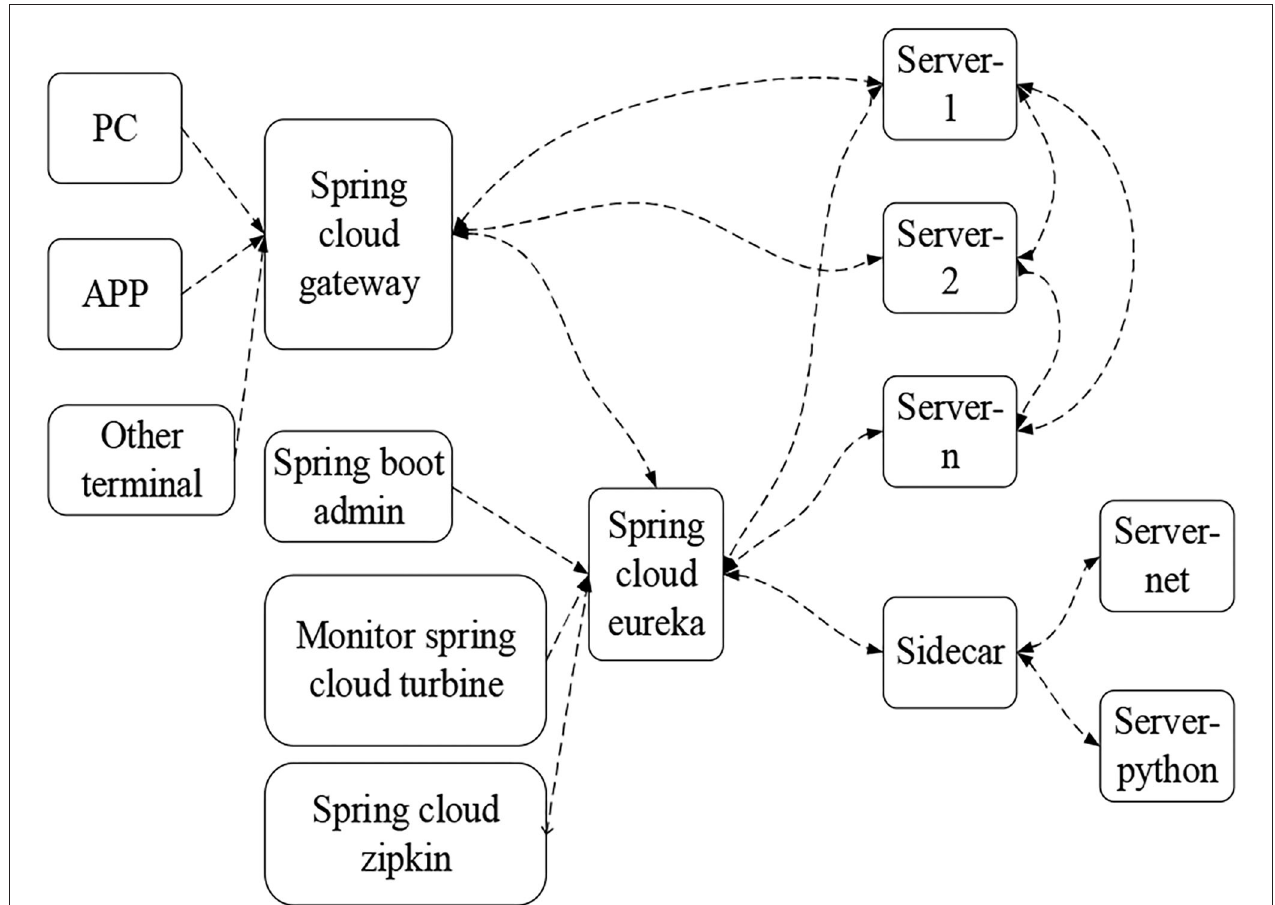
FIGURE 2 | Spring Cloud component